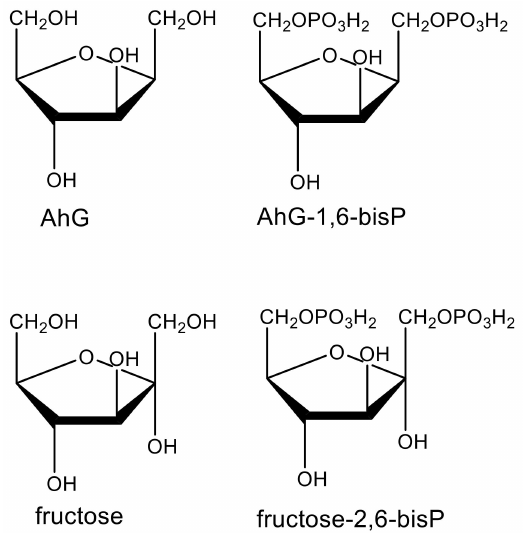
Figure 3. Structures of the fungal phytotoxin 2,5-anhydro- d -glucitol (AhG), fructose, and their phosphorylated